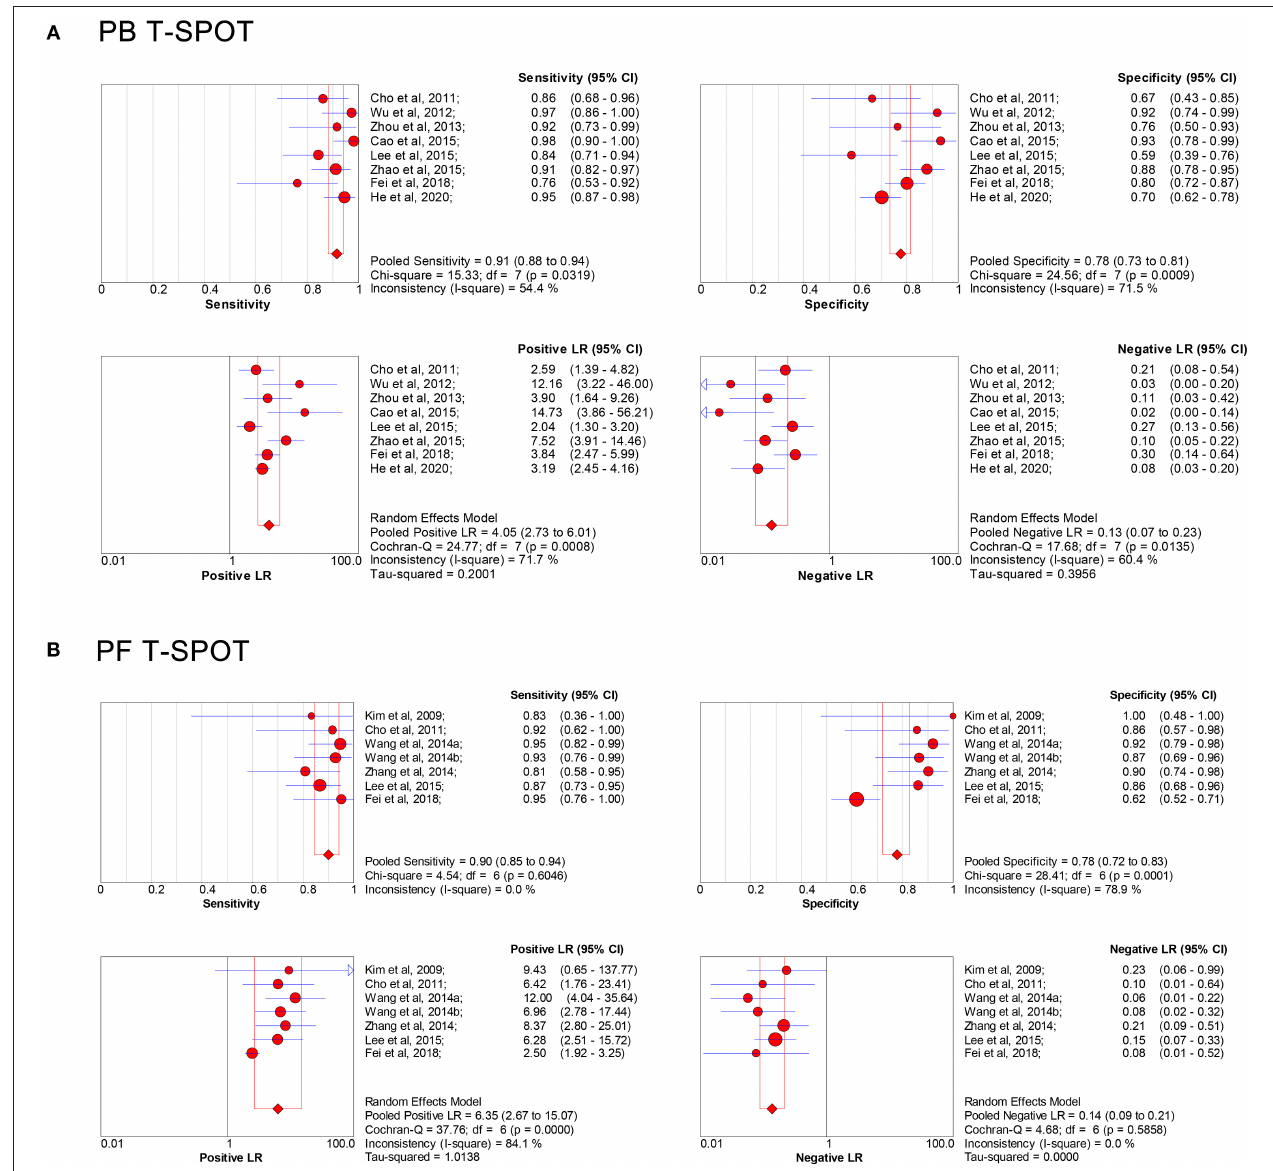
FIGURE 3 | Forest plot showing estimates of sensitivity, specificity, PLR, and NLR of PB T-SPOT (A) and PF T-SPOT (B) for diagnosing TP. Point estimates of sensitivity, specificity, PLR, and NLR from each study are shown as solid circles, whose size reflects the total number of cases and controls. Error bars show 95% CI. Numbers indicate the reference numbers of studies. PLR, positive likelihood ratio; NLR, negative likelihood ratio; PB, peripheral blood; PF, peritoneal fluid; TP, tuberculous peritonitis; CI, confidence